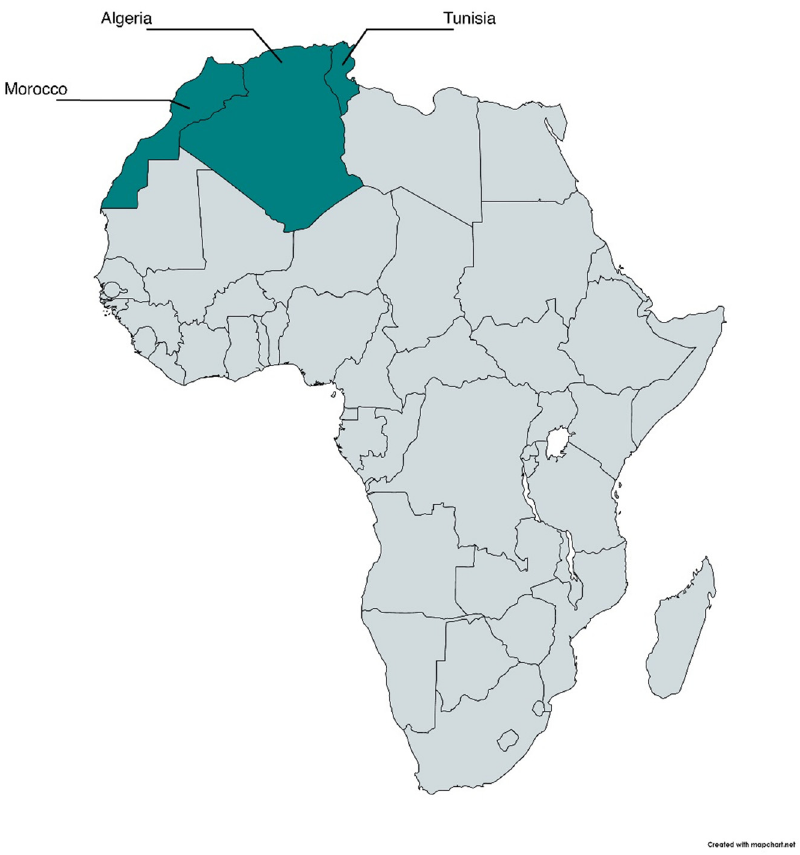
Figure 1: The main area of the